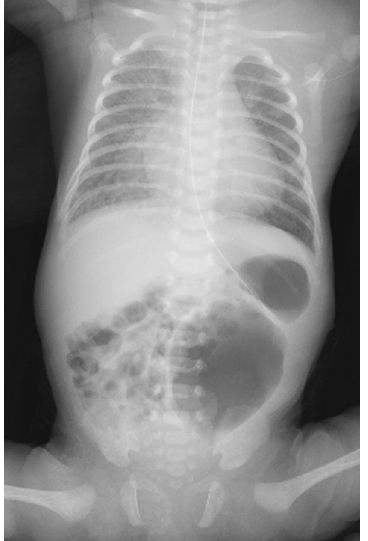
Fig. 1 Abdominal X-ray 1 day after birth. The abdominal X-ray showed a dilated intestine in the left lower abdomen